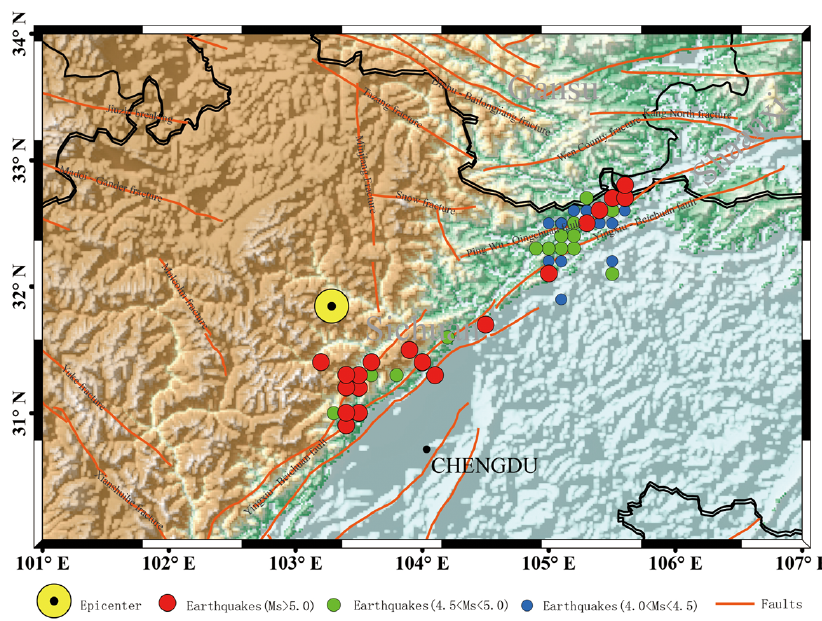
Figure 4. The investigated area of the Yingxiu-Beichuan fault seismic